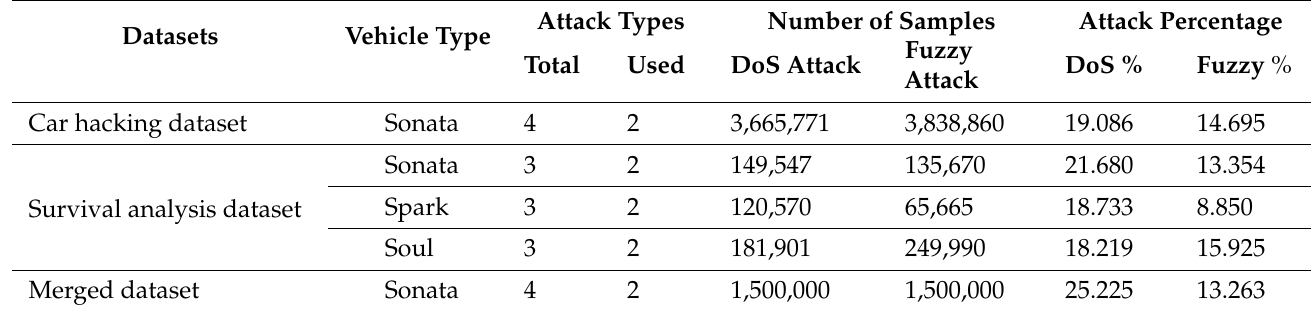
Table 4. Detailed description of datasets used in performance